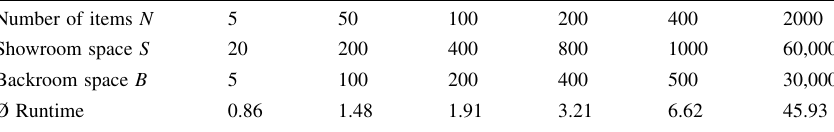
Table 4 Runtime tests for different problem sizes, in seconds Number of items